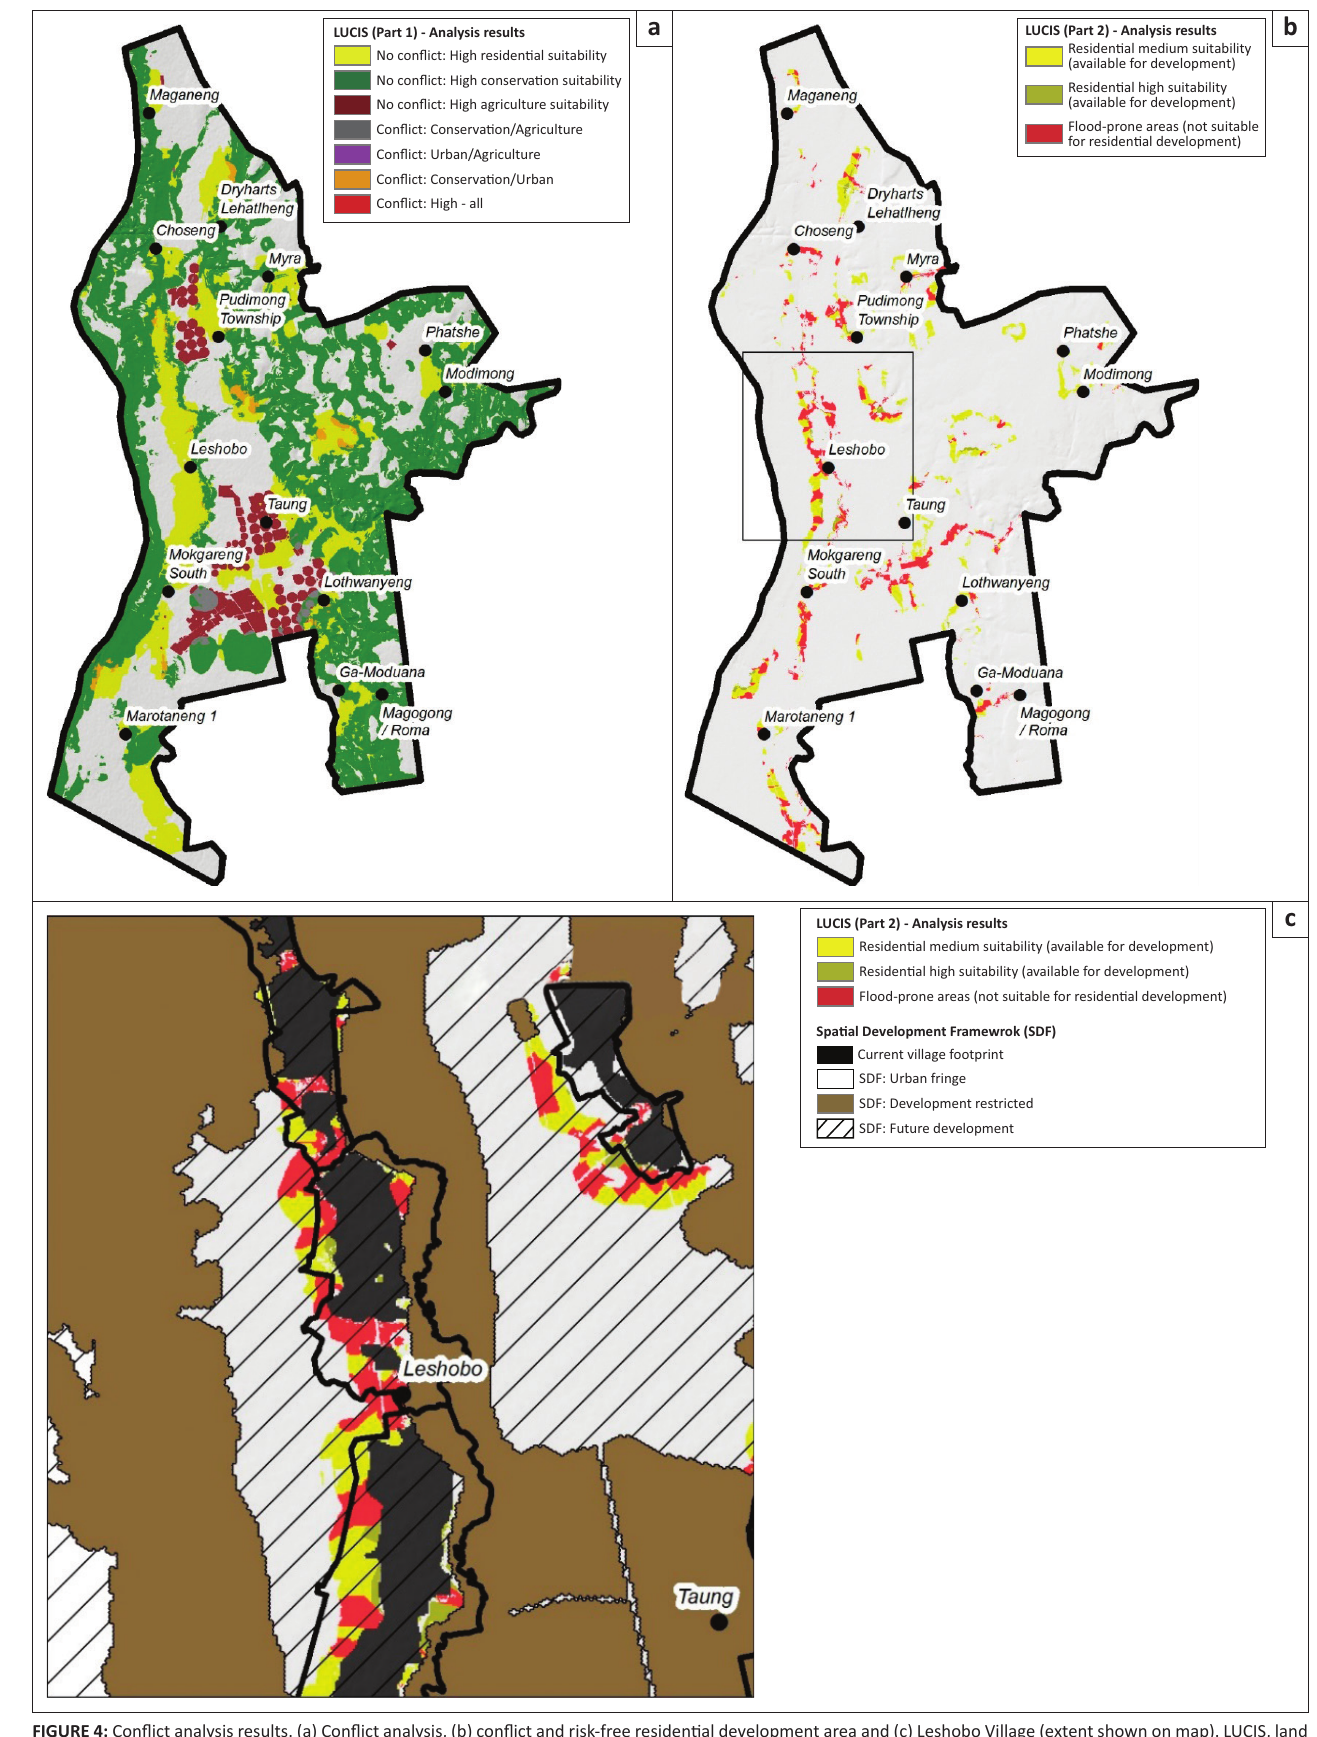
FIGURE 4: Conflict analysis results. (a) Conflict analysis, (b) conflict and risk-free residential development area and (c) Leshobo Village (extent shown on map). LUCIS, land use conflict identification